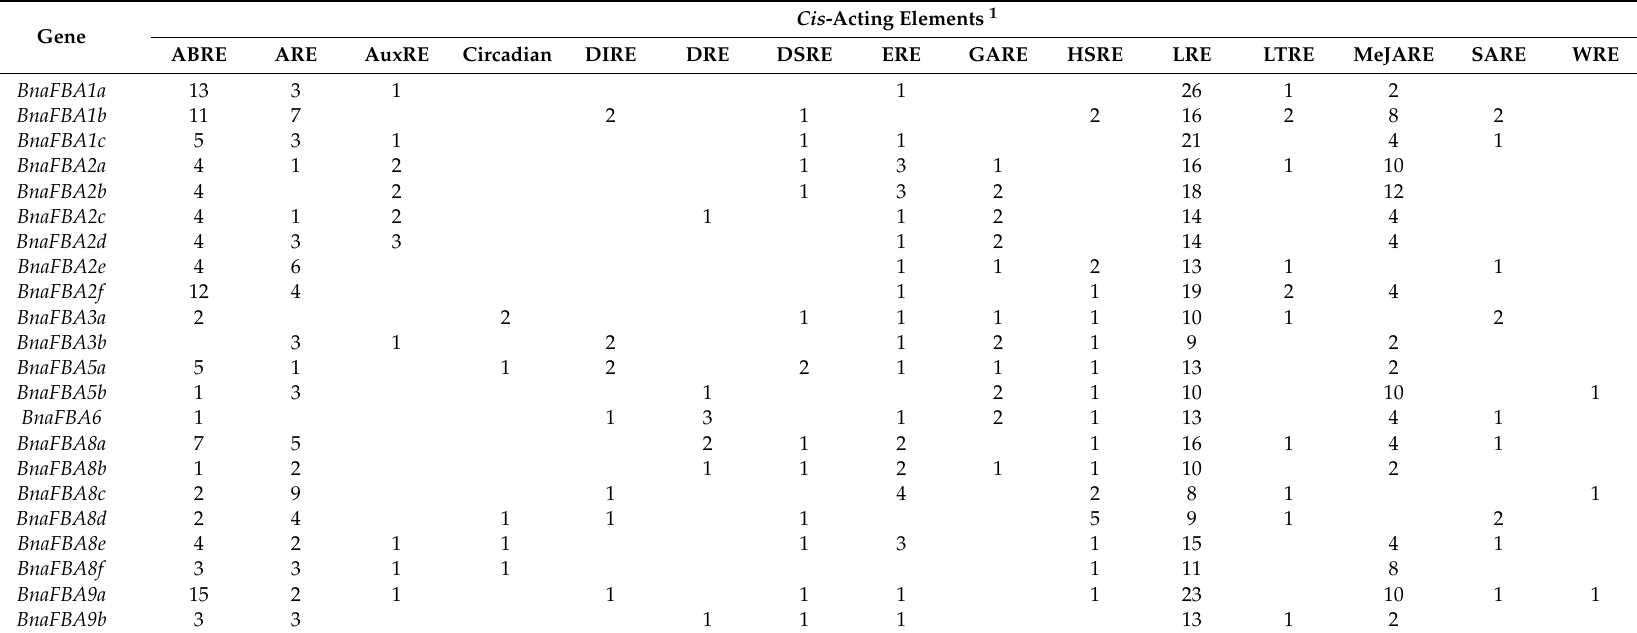
Table 2. Cis -Acting Elements in the Promoter Region of 22 BnaFBA